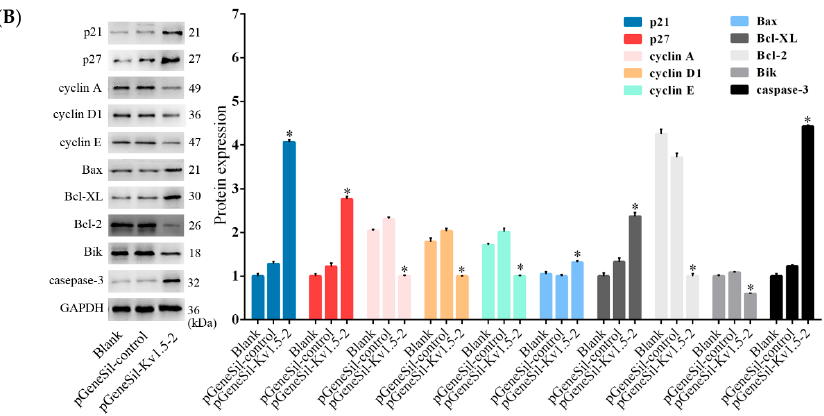
Figure 6. The expression of several crucial cell cycle and apoptosis related proteins in MG-63 cells after transfection with Kv1.5-shRNA. Representative qRT-PCR ( A ) and Western blot analysis ( B ) image showing significant increase of the expression of p21, p27, Bax, Bcl-XL and caspase-3, and significant decrease expression of cyclins A, cyclins D1, cyclins E, Bcl-2 and Bik. All data were normalized as the value obtained for blank group and presented as means ± SEM. * p < 0.05.